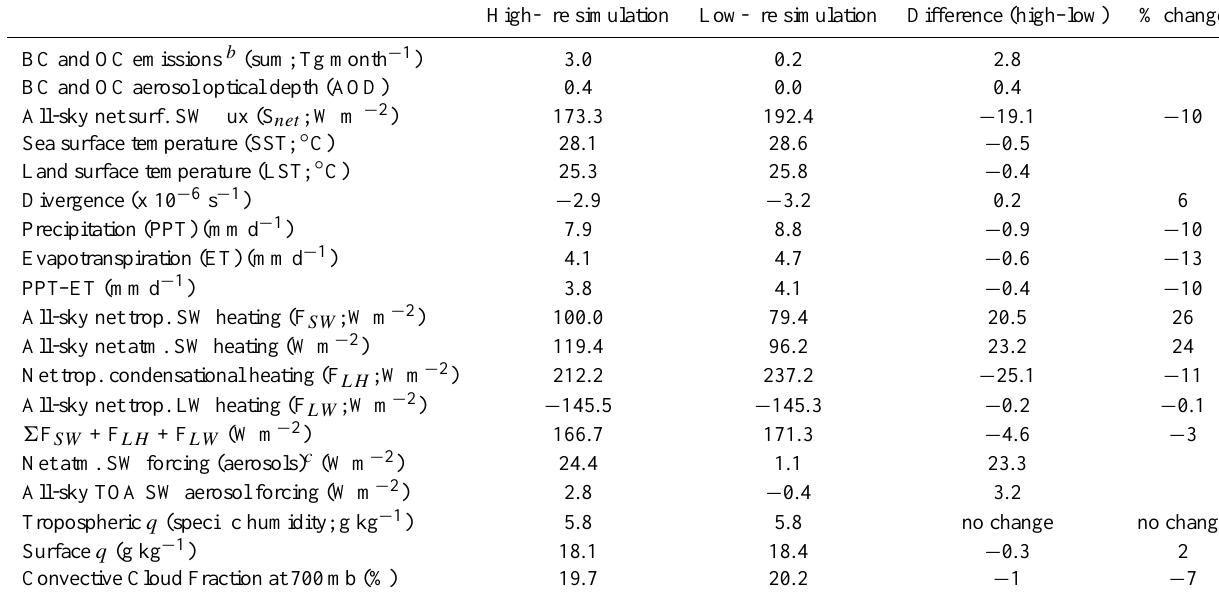
High-fire simulation Low-fire simulation Difference